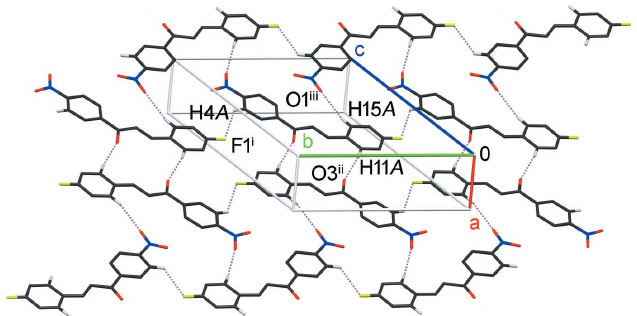
Figure 2 A partial packing diagram of the title compound, showing a two- dimensional sheet formed by C—H (cid:2)(cid:2)(cid:2) O and C—H (cid:2)(cid:2)(cid:2) F hydrogen bonds (dotted lines). H atoms not involved in hydrogen bonding are omitted for clarity. [Symmetry codes: (i) x , y + 1, z ; (ii) (cid:3) x + 2, (cid:3) y + 1, (cid:3) z + 1; (iii) (cid:3) x , y (cid:3) 1